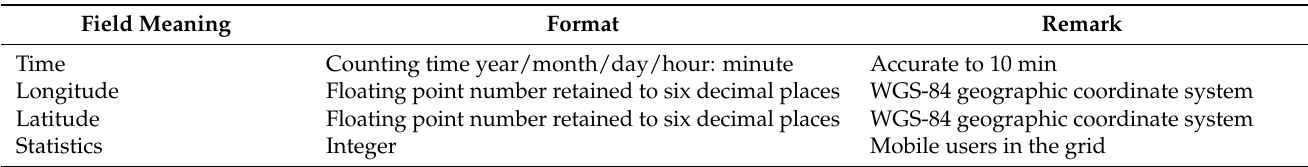
Table 1. Field descriptions of mobile phone signaling data.